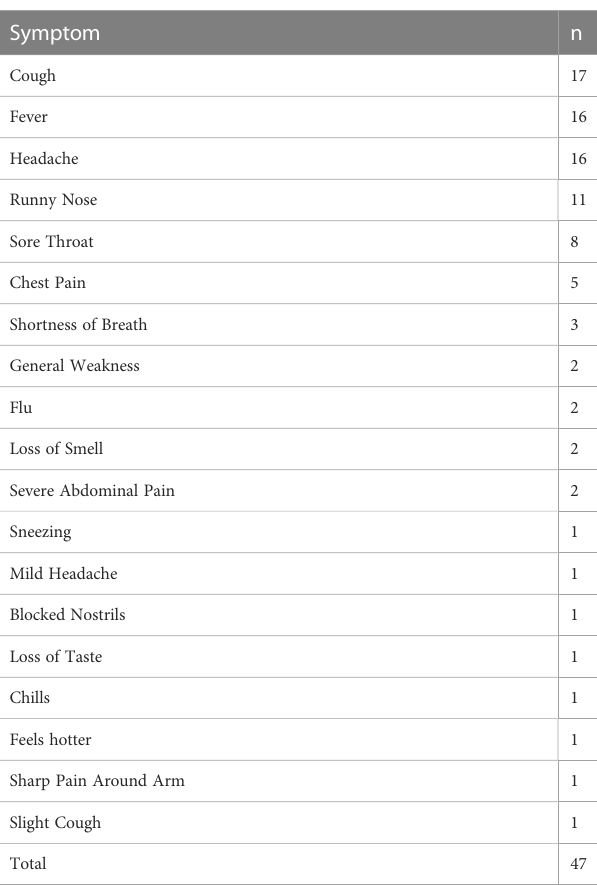
TABLE 1 Summary of recorded admission